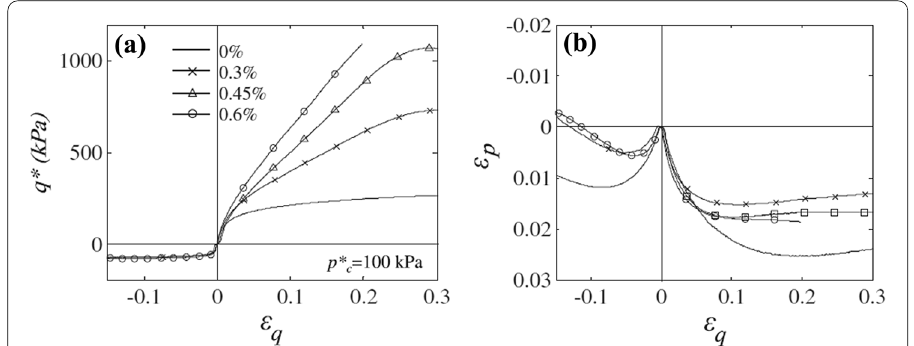
Fig. 1 a Deviator stress-shear strain and b Volumetric strain-shear strain response for drained triaxial tests on unreinforced and reinforced samples with different fibre percentages, isotropically consolidated to 100